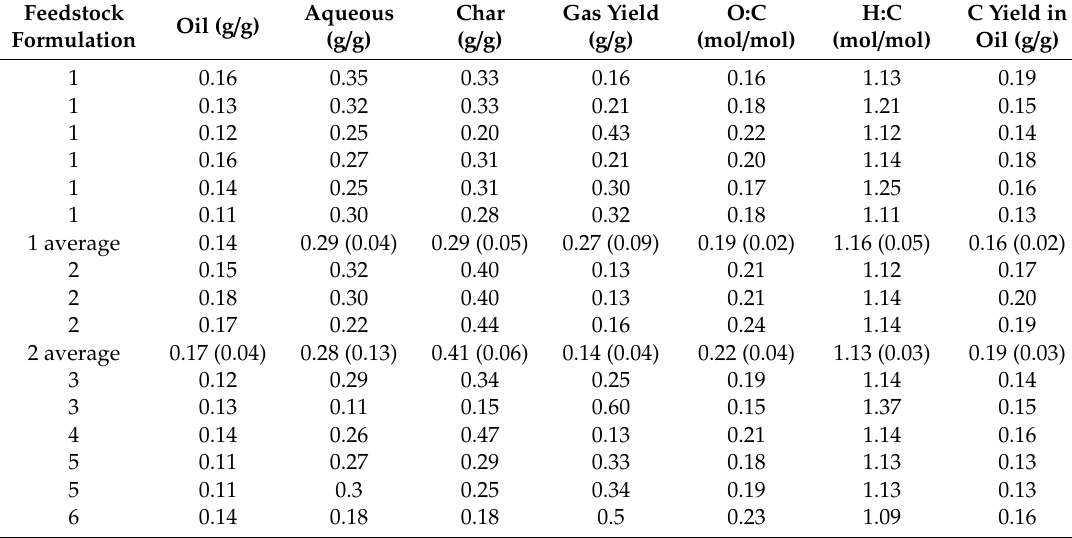
Table 3. Mass yields and CHO data for pyrolysis of magnesium-formate-pretreated lignin.